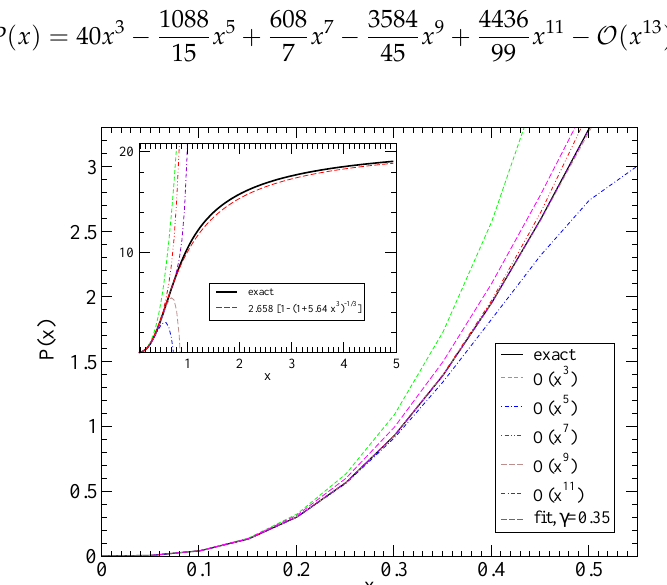
Figure A1. The function P(x) defined in Equation (A28) with its polynomial expansions in different lowest orders, as well as a fit that obeys both limits of P ( x → 0 ) = 40 x 3 and P ( x → ∞ ) = 12 main panel the range of applicability of the low-density approximation is shown, a larger picture is shown in the